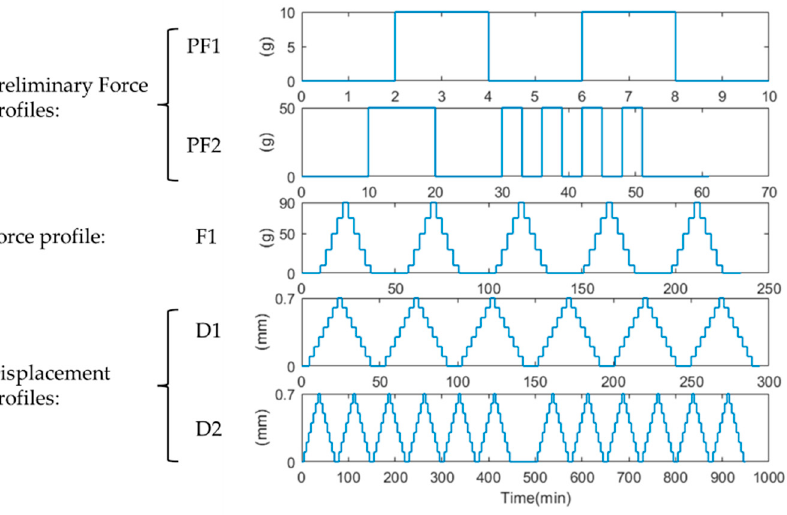
Figure 3. From top to bottom: two preliminary force profiles (PF1 and PF2), Force profile 1 (F1), Displacement profile 1 (D1), and Displacement profile 2 (D2).